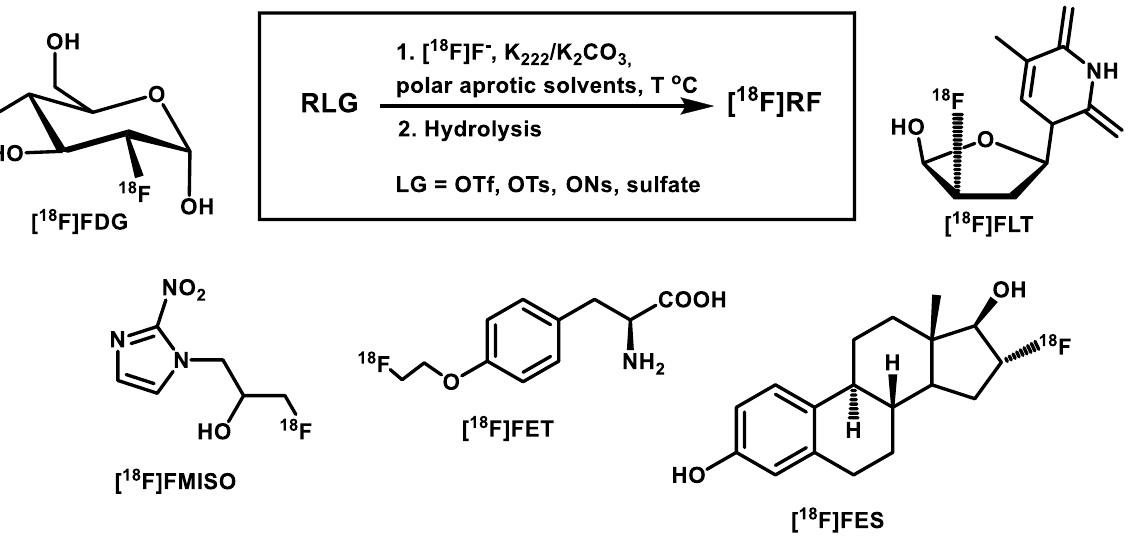
Figure 1. The structures of the commonly used tumor seeking agents prepared by conventional ali- phatic radiofluorination. aliphatic